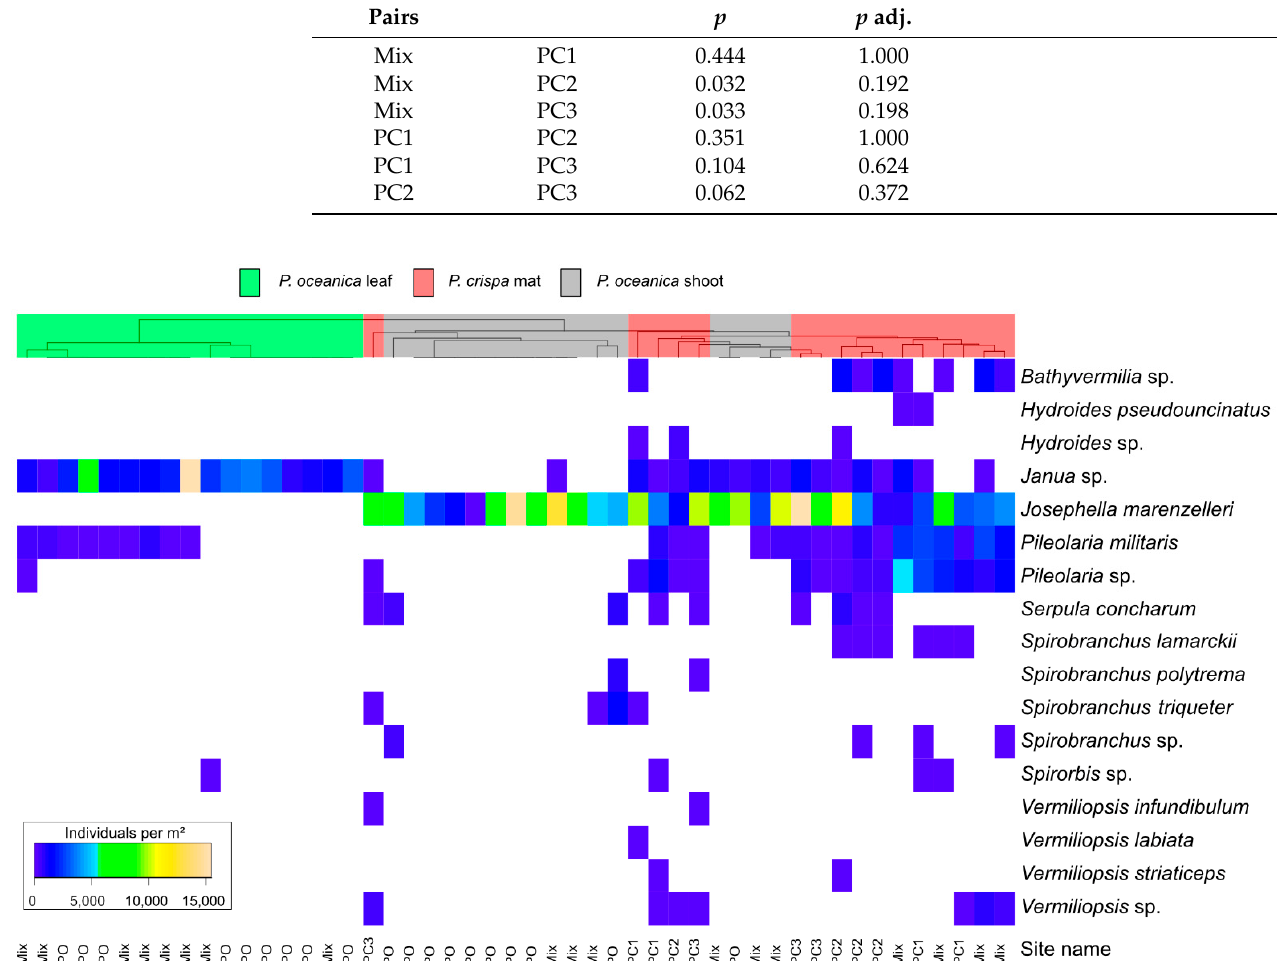
Figure 4. Hierarchical clustering (average linkage, Spearman ranked correlation) of taxa abundances among sites (individu- als per m 2 ) found in P. crispa (red) and P. oceanica habitat northern sites (green = leaf; grey =